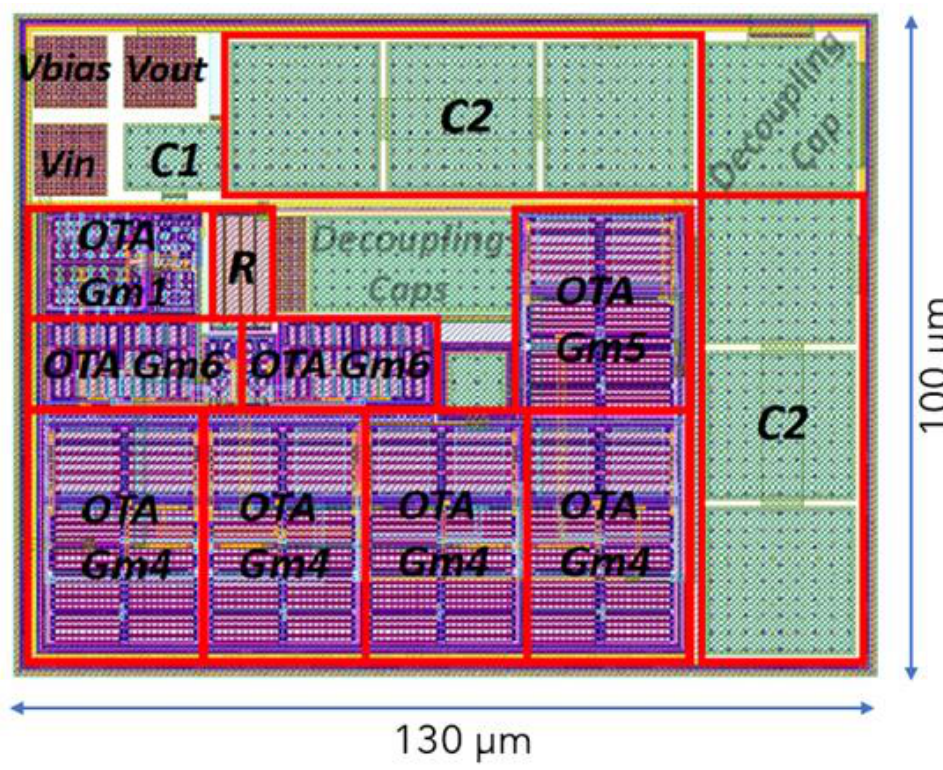
Figure 22. Layout of the optimized bandpass filter.